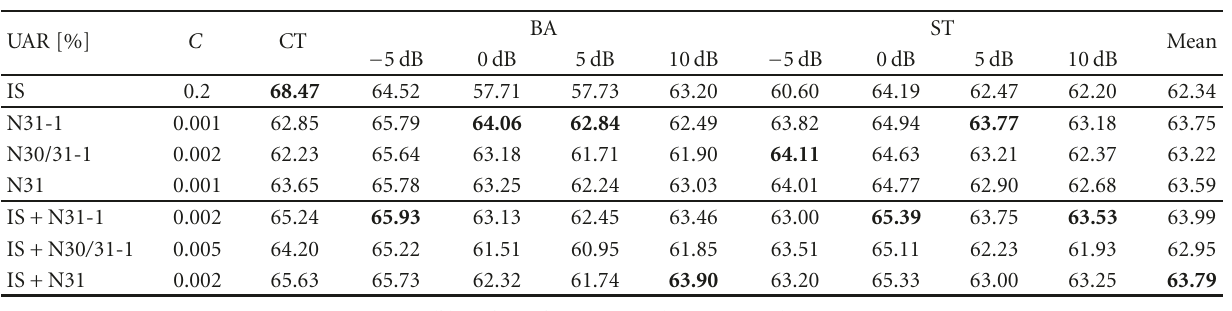
Table 5: Results on the Aibo 2-class problem with additive noise (8257 test instances) for di ff erent training conditions. The following test conditions were considered: CT (clean), BA (babble noise at − 5–10dB SNR), and ST (street noise at − 5–10 dB SNR). All results